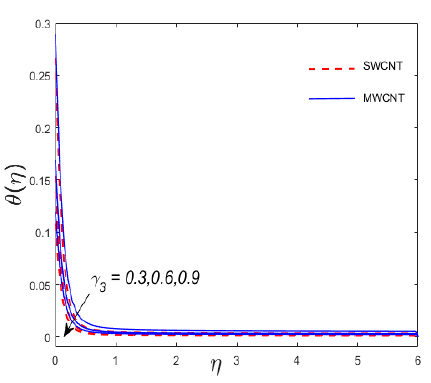
Figure 9. Outcome of Fr vs. f (cid:48) ( η ) .